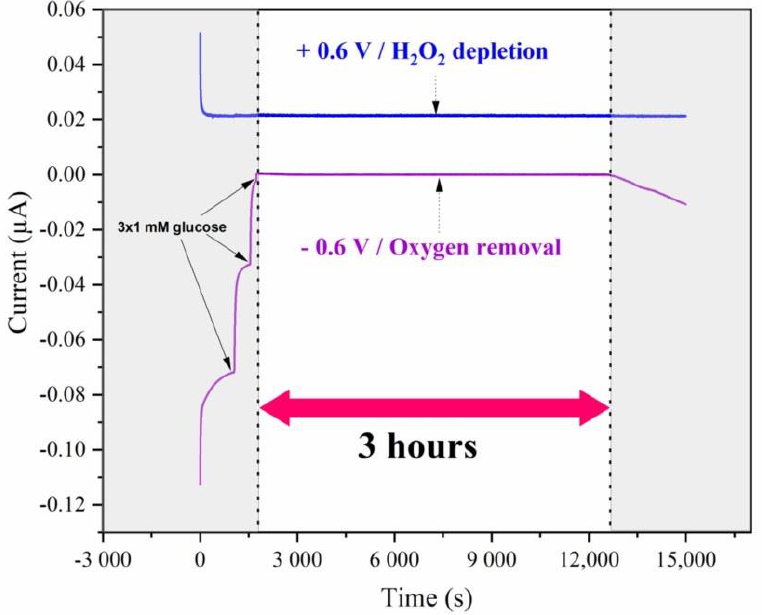
Figure 1. Performance of the scavenging membrane containing 10 U GOD and 1000 U Cat in 3% PVA. Current traces of the Clark electrode polarized at − 0.6 V (purple curve: O 2 removal) and +0.6 V (blue curve: H 2 O 2 monitoring) after three additions of 1 mM glucose each. Measurements were performed under ambient air conditions in a Sörensen buffer solution (pH 7) containing 100 mM KCl.